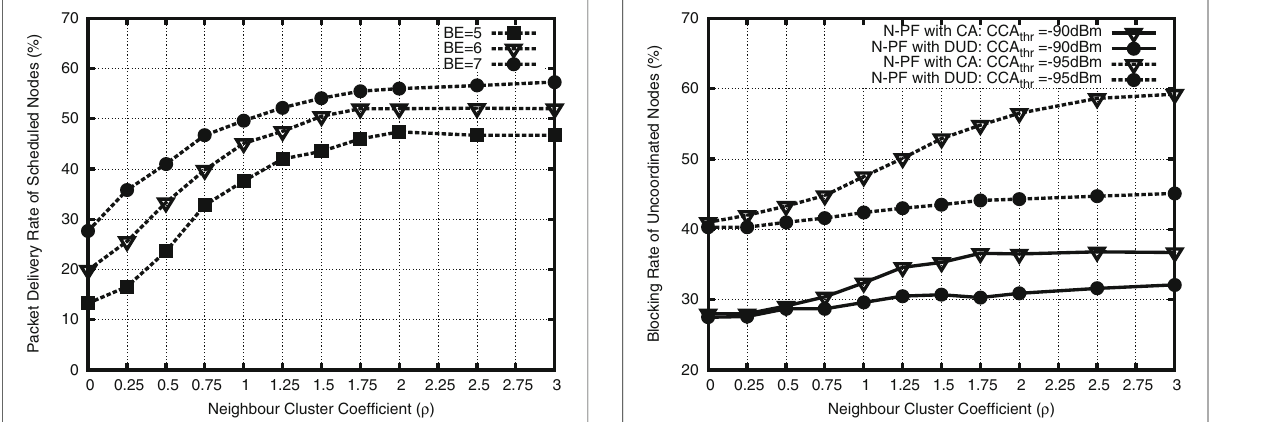
the overall channel utilization index as a function of ρ is shown. As can be seen, both the use of N-PF and CA improve the channel utilization.